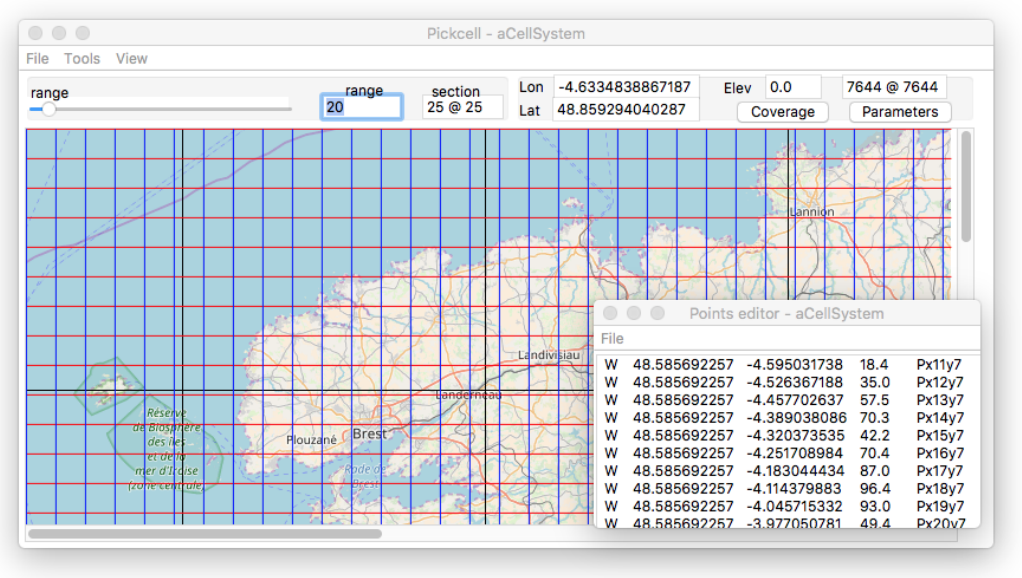
Figure 10. Presentation of a cell system organization over the tiles of Figure 8. Each cell has an identity produced from its location inside the window, and a geographical location. The text window bottom right also displays a plus parameter for the elevation. The cell size is 25 × 25 pixels, representing 7644